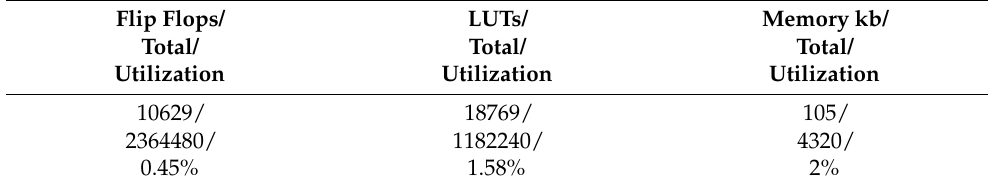
Table 2. Resource